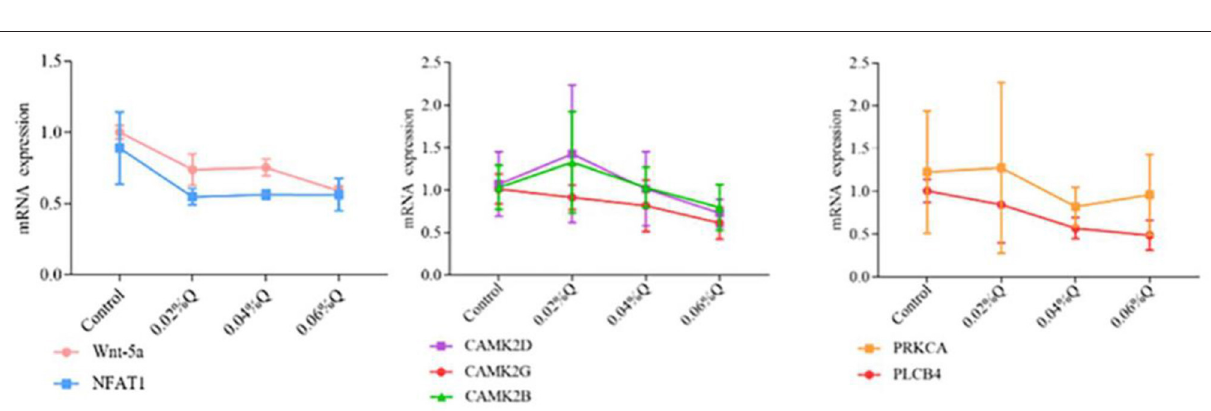
FIGURE 5 | Effect of quercetin on mRNA expression of genes related to calcium and phosphorus metabolism in duodenal mucosa. (1) The results of relative quantification are expressed as 2 − 11 CT . The quantification of control is 1, namely 2 − 11 CT = 1. The value 2 − 11 CT of the treatment group is a multiple of control. n = 6. (2) Mean values without a common letter are significantly different, P < 0.05. Values are mean ± SEM ( n = 6). 0.02, 0.04, and 0.06%Q represent 0.02% quercetin, 0.04% quercetin, and 0.06% quercetin,